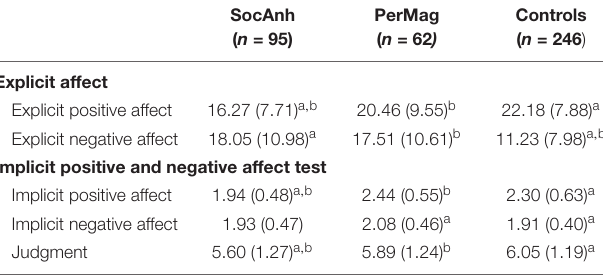
TABLE 1 | Means (SDs) and group differences for questionnaire and task